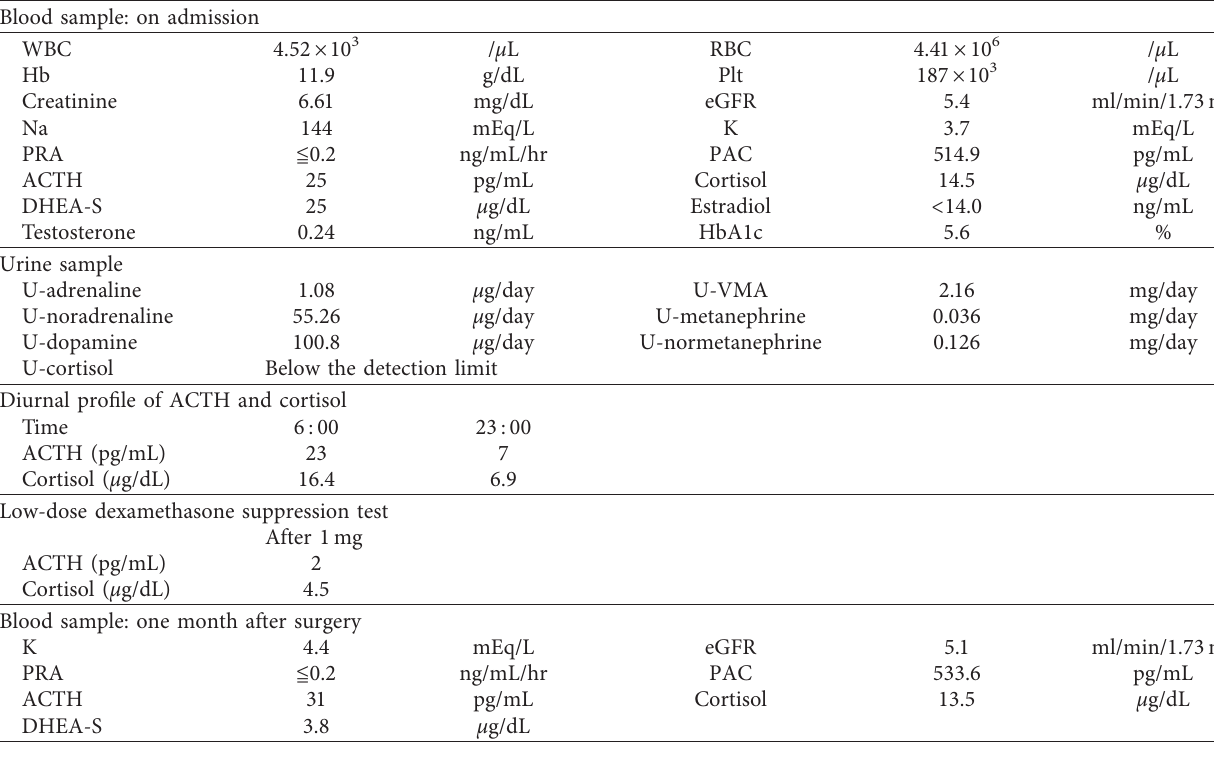
Table 1: Plasma parameters.